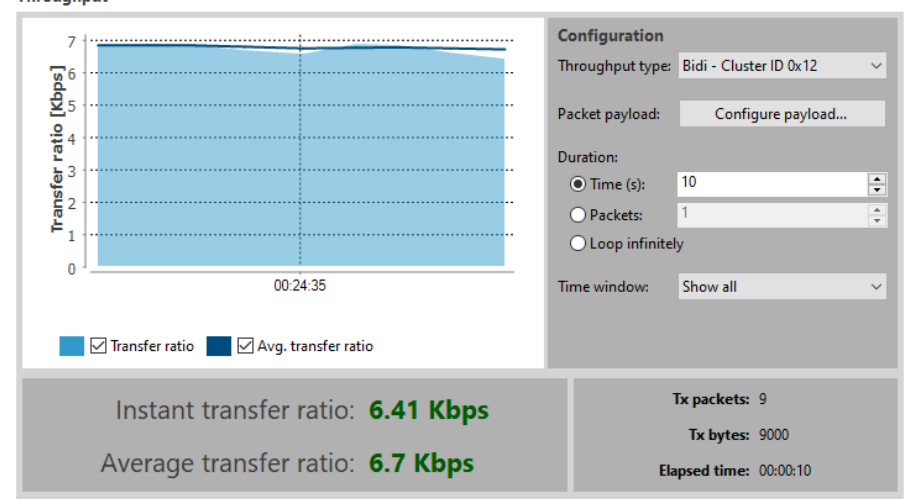
Figure 20. Measured ZigBee throughput in indoor environment.